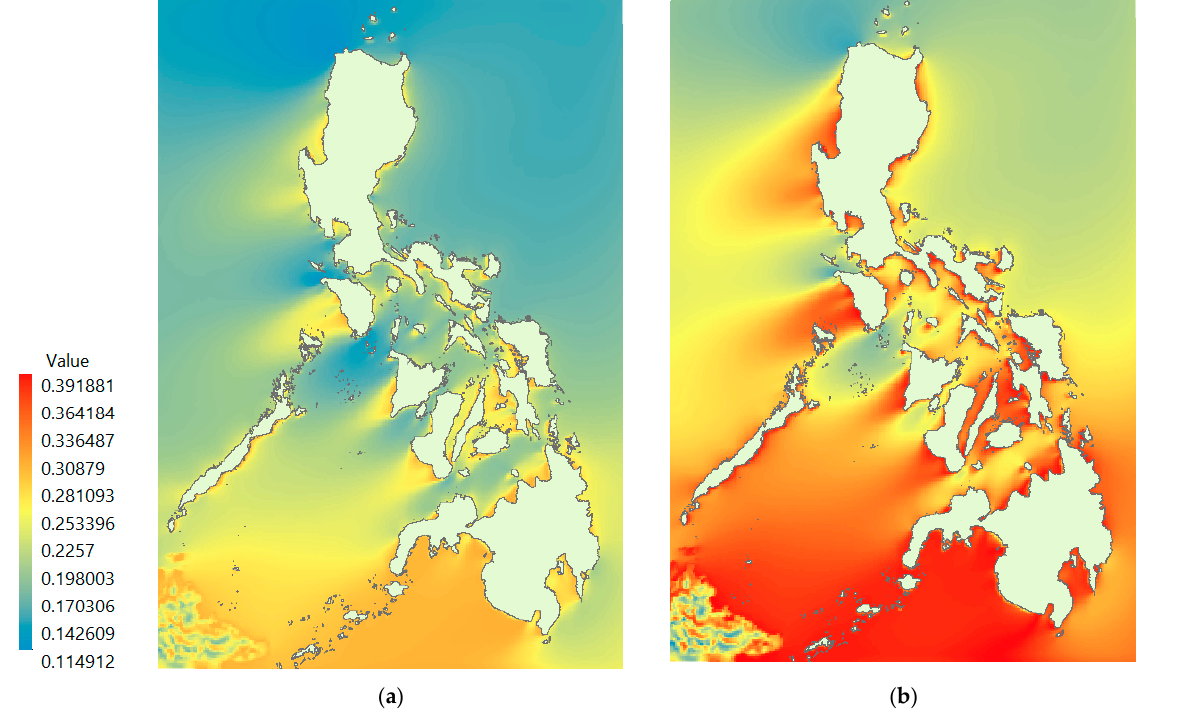
Figure 21. Black contours with less than 30% capacity factor for ( a ) SWT-3.6-120, ( b ) 6.2M126.